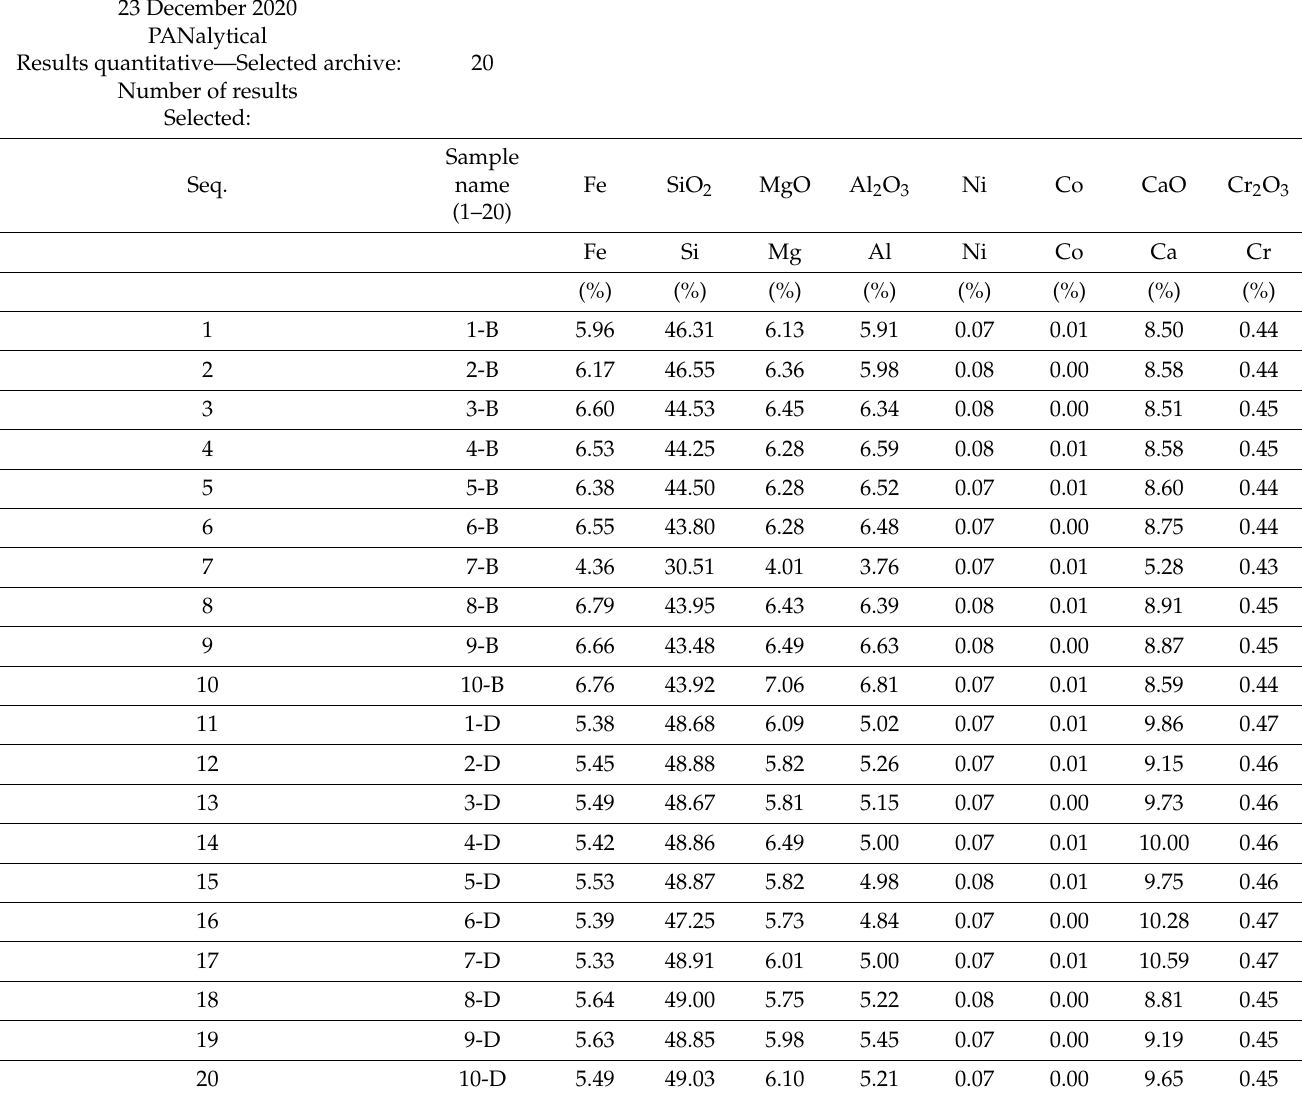
Table 1. Brari and Dardha clay composition